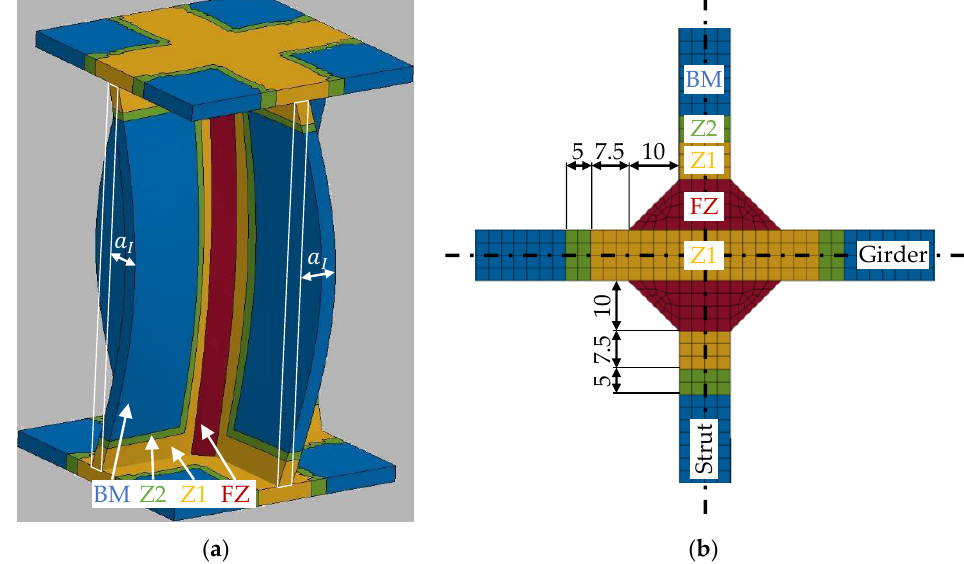
Figure 15. Geometry of the X-profile: ( a ) X-profile with a scaled idealized imperfection; ( b ) cross section in LS-DYNA with dimensions of the material zones.